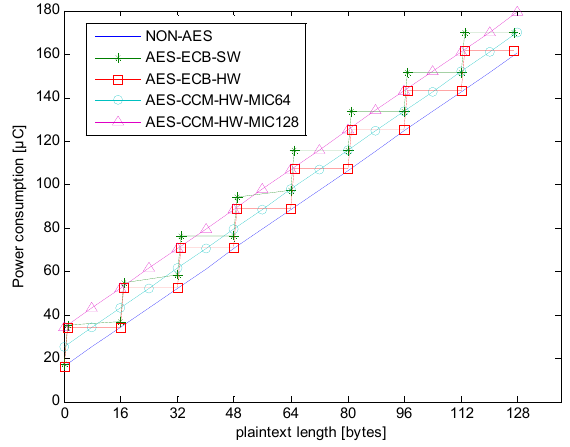
Figure 8. Total power consumption of different encryption types.